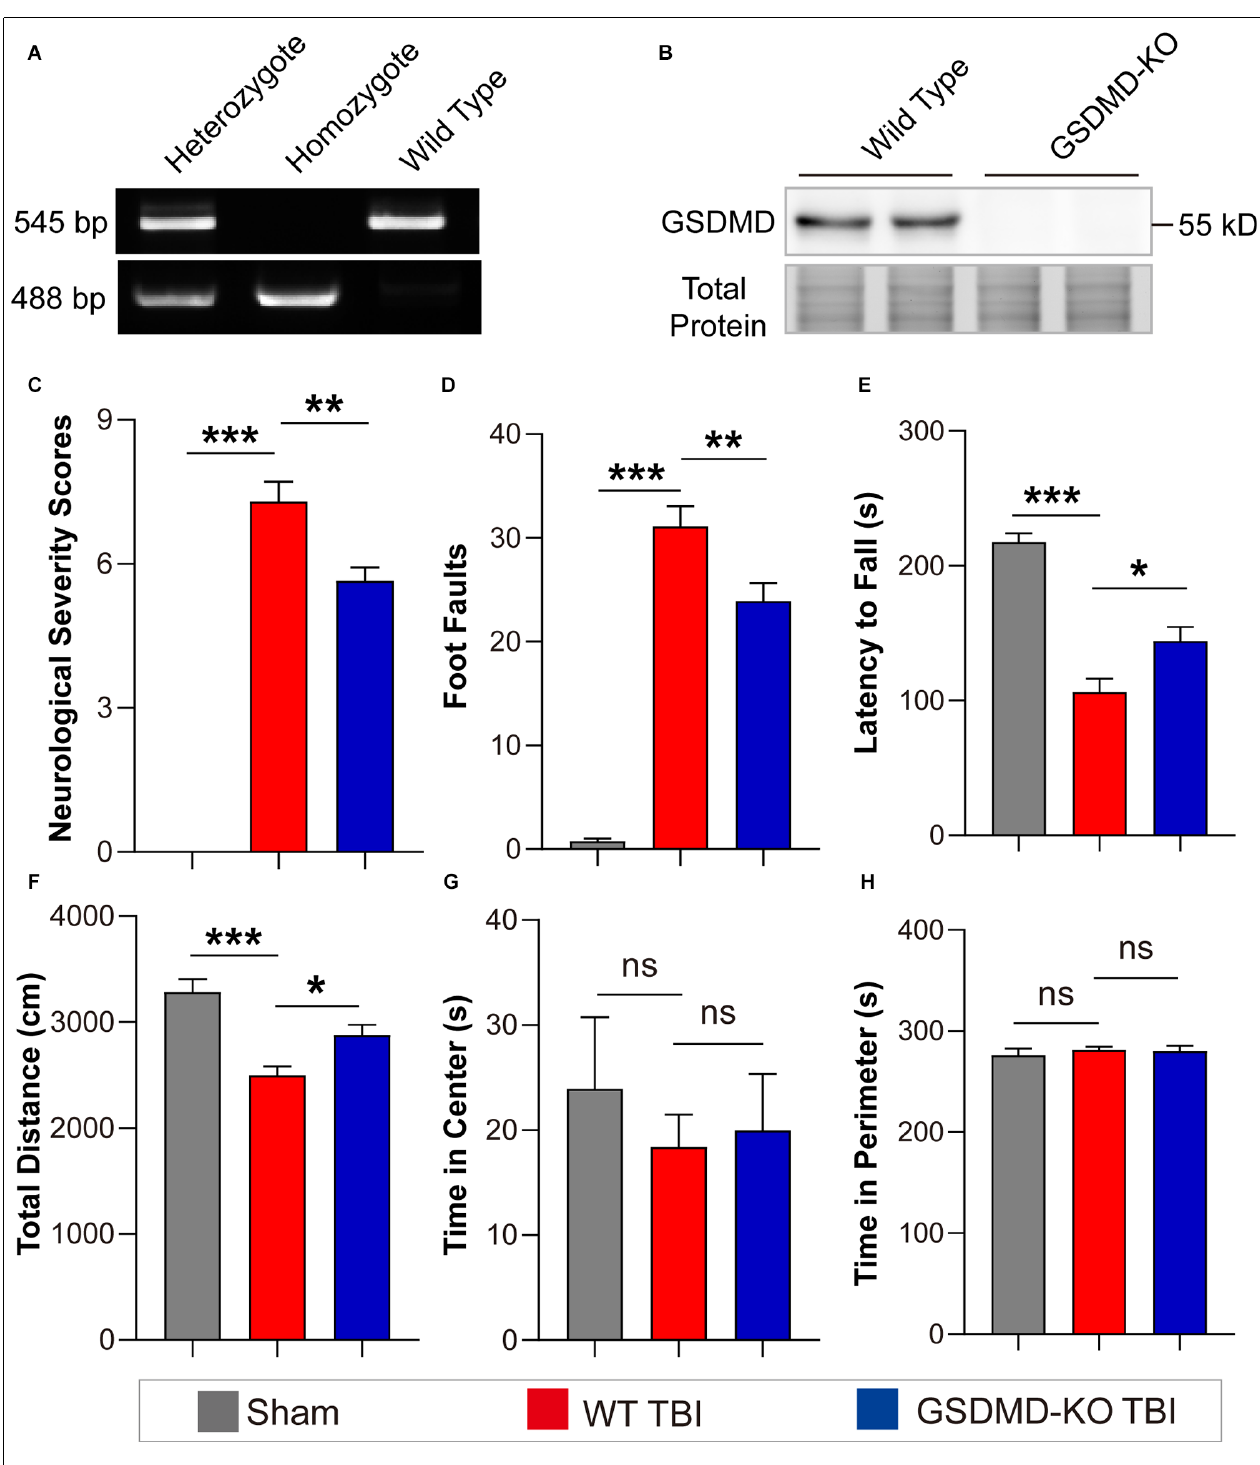
FIGURE 2 | GSDMD-KO attenuated neurological deficits at 3 days after TBI. (A) Representative images of agarose gel electrophoresis for GSDMD-KO mouse genotyping. (B) Representative images of immunoblots for GSDMD using brain samples from WT mice and GSDMD-KO mice. (C–E) Quantitative analysis of NSS scores, foot faults, and latency to fall (s) from NSS test, beam walk test, and accelerating rotarod test at 3 days after TBI ( n = 9–10). (F–H) Quantitative analysis of total distance (cm), time in center (s), and time in perimeter (s) in the open field test at 3 days after TBI ( n = 9–10). All data are presented as the mean ± SEM and were analyzed using one-way ANOVA followed by Tukey’s multiple comparisons test for significance. ns p > 0.05, * p < 0.05, ** p < 0.01, and *** p < 0.001.